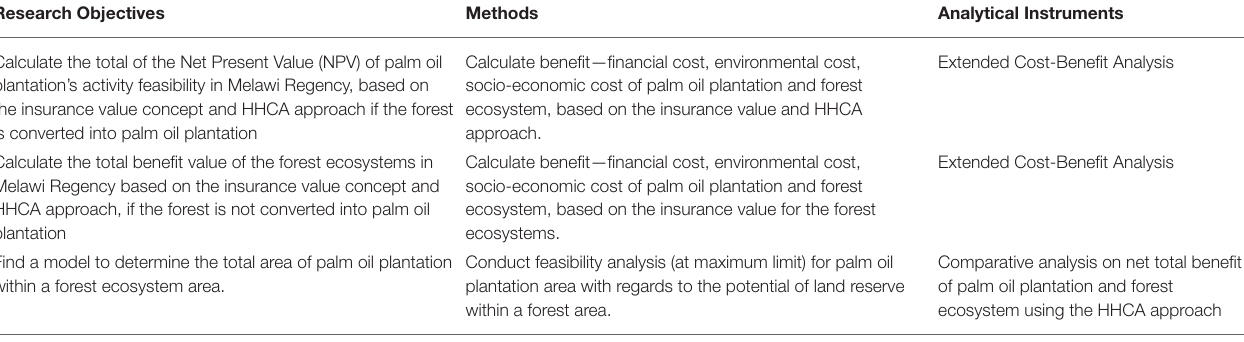
TABLE 1 | Methods to answer research objectives. Research Objectives